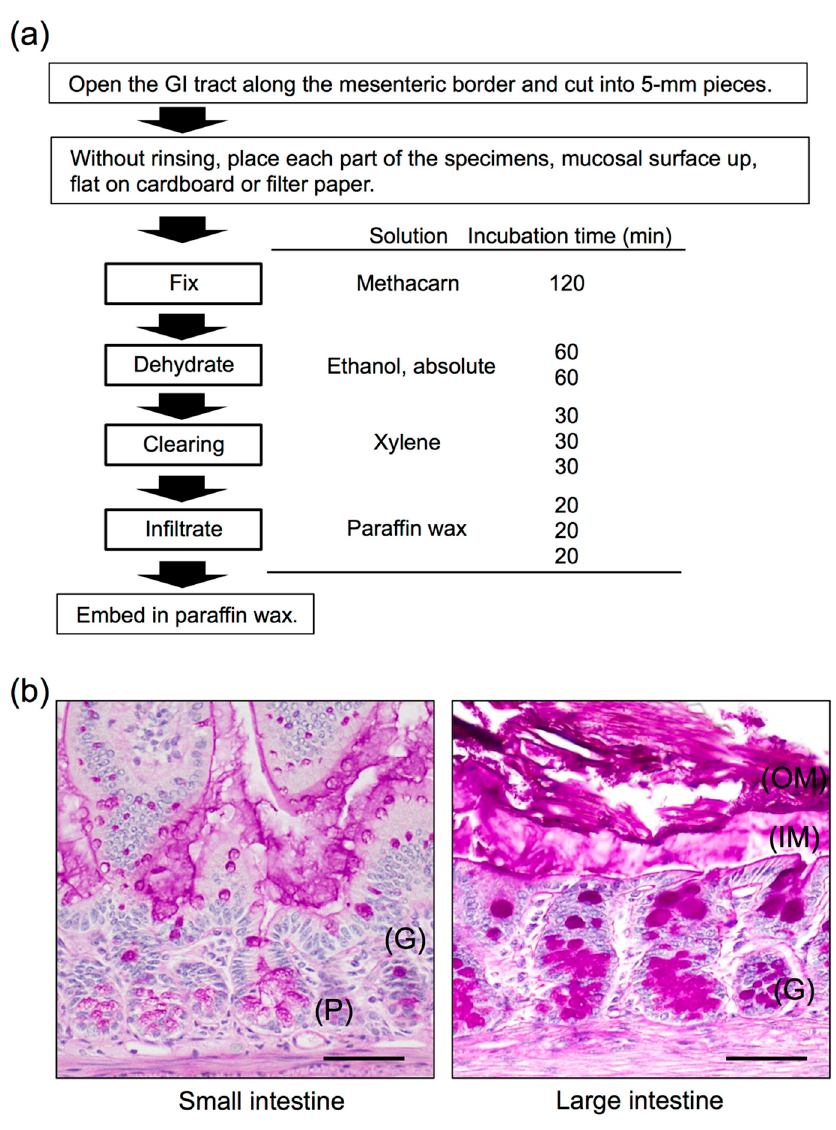
Figure 2. Histology of the mouse small and large intestines. (a) Methacarn fixative and paraffin embedding procedure and methods, based on Puchtler’s protocol [41]. (b) Transverse sections of a 12-week-old male mouse small intestine (jejunum) and large intestine (colon). Methacarn fixative, periodic acid-Schiff stain. OM, outer mucus; IM, inner mucus; G, goblet cells; P, Paneth cells. Scale bars: 100 µ m. Based on the results of Nishiyama et al. [47].